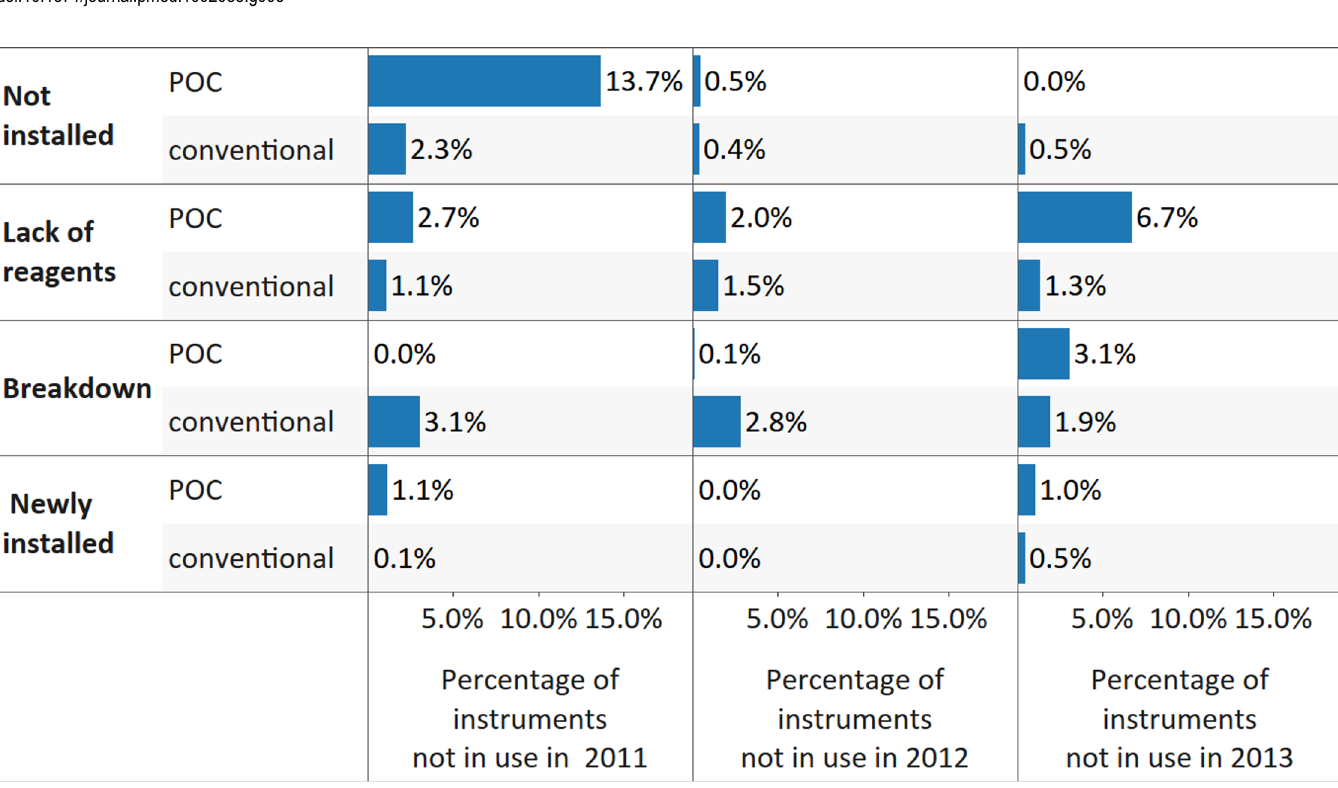
Fig 6. Reasons provided for nonutilization of CD4 instrumentation, for all reporting countries, disaggregated by platform. Data labels indicate the percentage from total number of reported CD4 point of care (POC) or conventional instruments in a particular year.